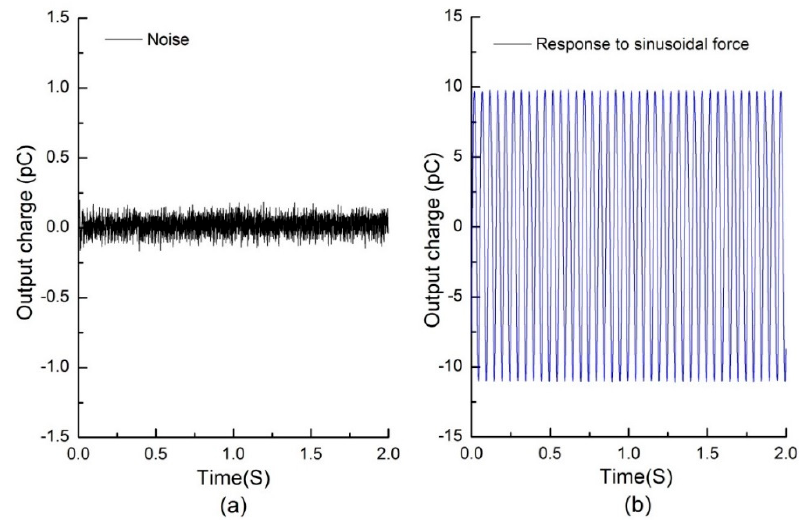
Figure 10. ( a ) The response of a piezoelectric capacitor in a tactile unit when no force was applied; and ( b ) the response of a piezoelectric capacitor when a 20 Hz sinusoidal force in z-axis direction with amplitude of about 5 N was applied on top surface of the tactile unit.